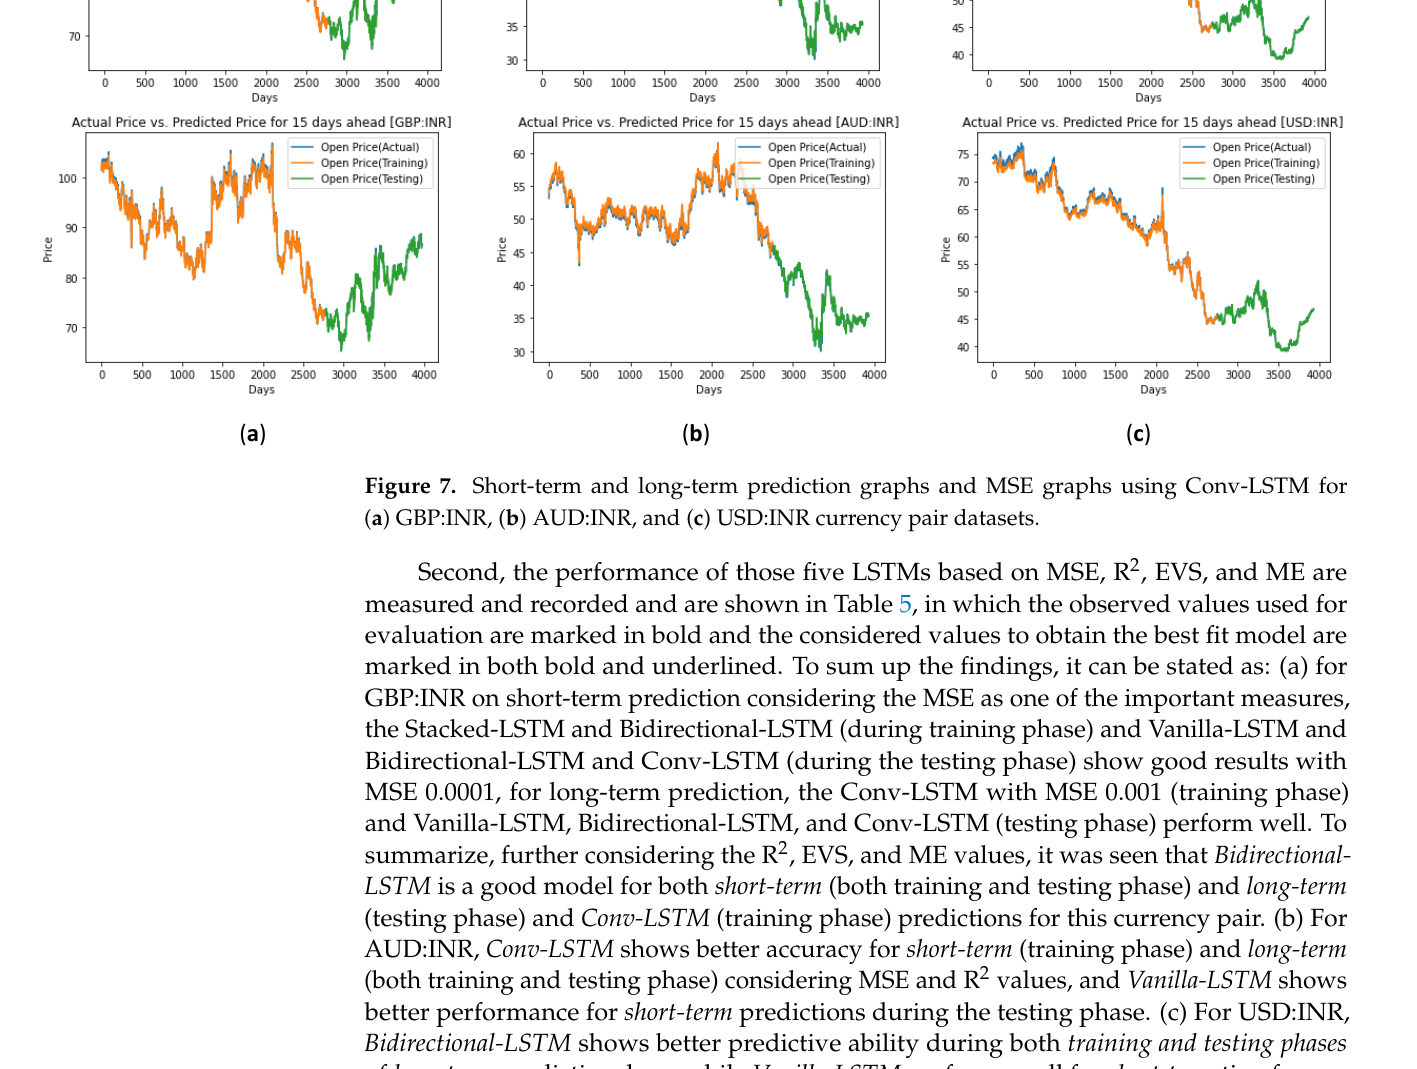
Table 5. Recognition performance in training and testing phases for all three currency pairs and for